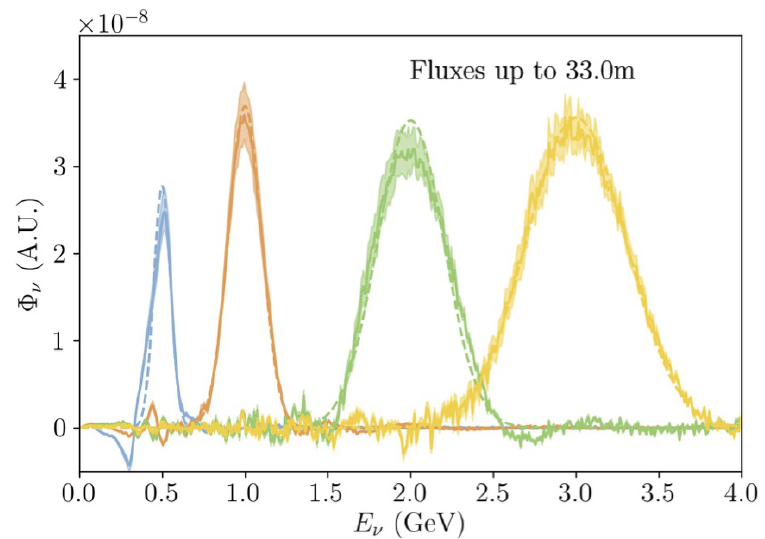
Figure 109. Linear combinations of ND ν µ off-axis fluxes used to produce Gaussian incident neutrino energy spectra. These are shown for four different selected energies, each with a 10%